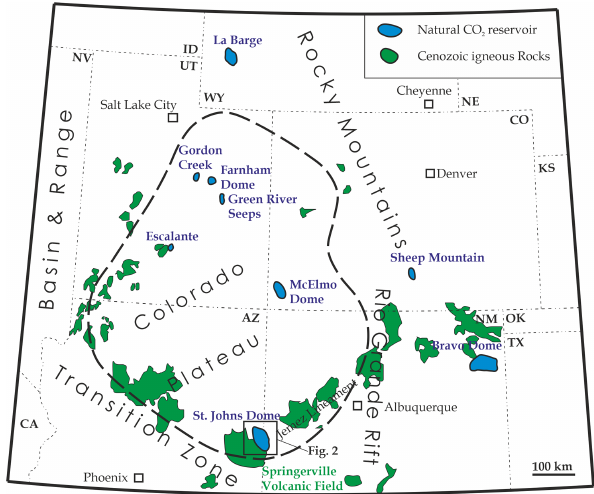
Figure 1. Map showing the location of natural CO 2 reservoirs and major late Cenozoic igneous rock occurrences on the Col- orado Plateau and adjacent areas (after Aldrich and Laughlin, 1984; Bashir et al., 2011; Moore et al., 2005). The St. Johns Dome reser- voir is located on the southern edge of the plateau, next to the Springerville volcanic